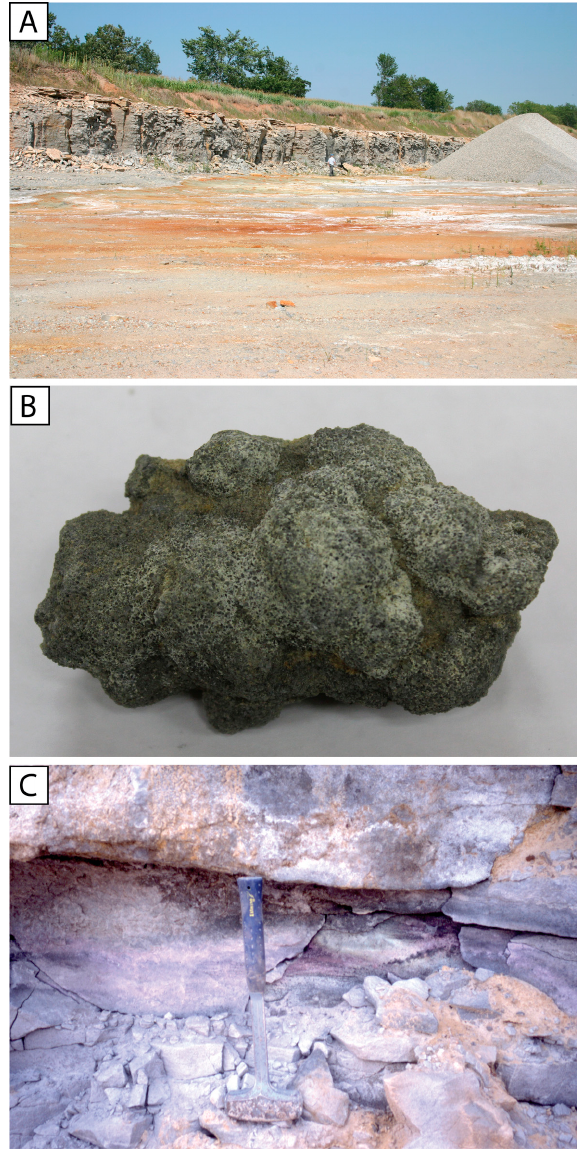
Figure 5. Exposures of the Sulfide Cement Horizon (SCH) in the upper portion of the St. Peter Sandstone (Ancell Group): ( A ) Discolored floor of a dolostone quarry showing the chemical alteration present at the top of the SCH at Location 34 in Oconto County. The quarry wall is the overlying Platteville Formation of the Sinnipee Group (human for scale). ( B ) A typical nodule of pyrite and/or marcasite-cemented quartz sandstone from the SCH at Locality 84 in Outagamie County (96-OUT-1), about 9 cm wide here. ( C ) Pink coating on Sulfide Cement Horizon at Locality 82 in Winnebago County (hammer for scale).